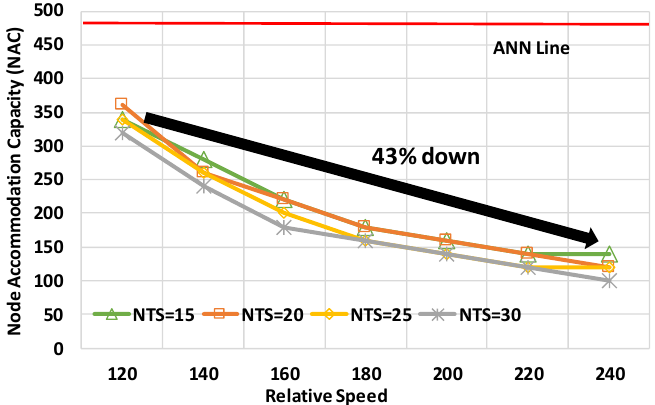
Figure 14. NACs for relative speed in the uniform distribution model.